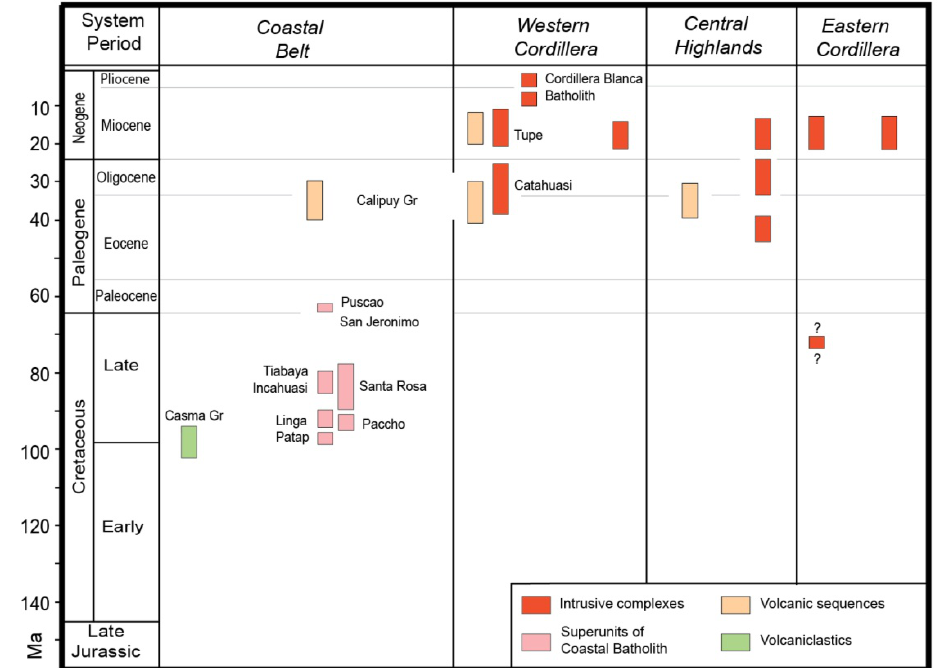
Figure 5. Temporal and spatial distribution of magmatic rocks in the Central Andes. References for ages are discussed in the text. Lengths of bars reflect age